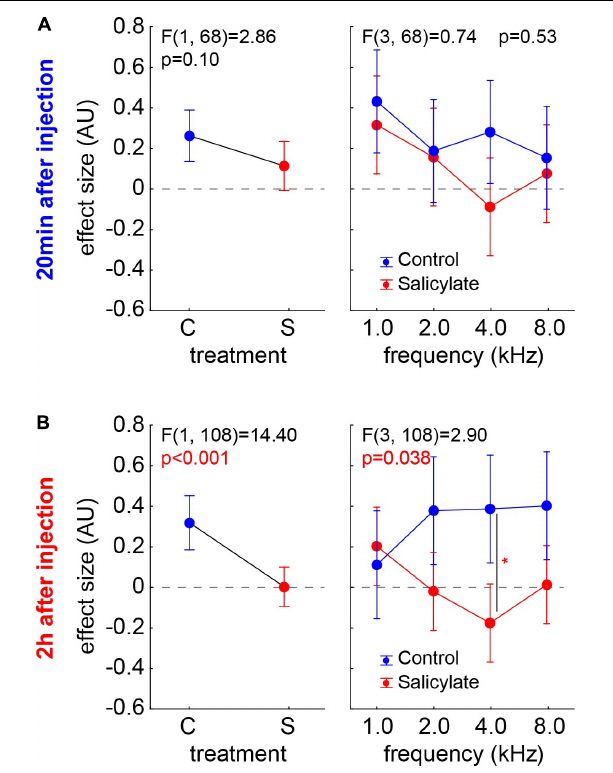
FIGURE 6 | Effect sizes of both animal groups (left panels) and their interaction with the factor frequencies (right panels) in two-factorial ANOVAs independent for the two time points. (A) 20 min after injection (group C, n = 9; group S, n = 10) – no significant effects are found. (B) 2 h after injection (group C, n = 9; group S, n = 19), the effect size was strongly dependent on the group and also shows a significant interaction, with the Tukey post hoc test becoming significant at 4 kHz ( p =